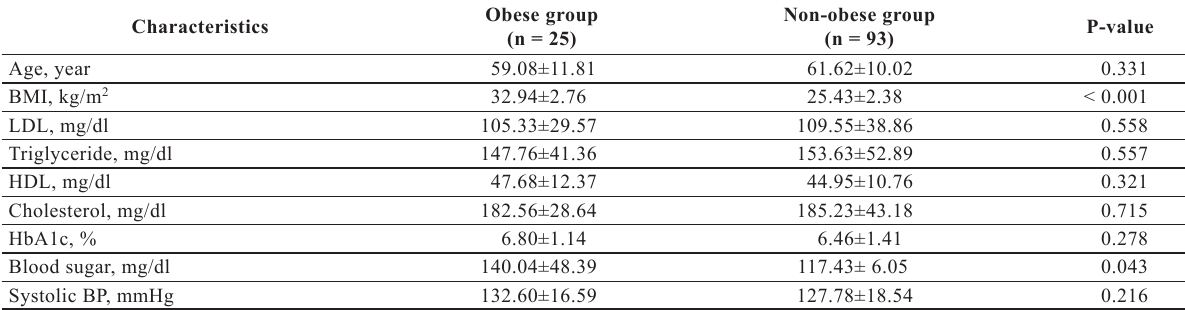
Table 1. Baseline characteristics between obese and non-obese